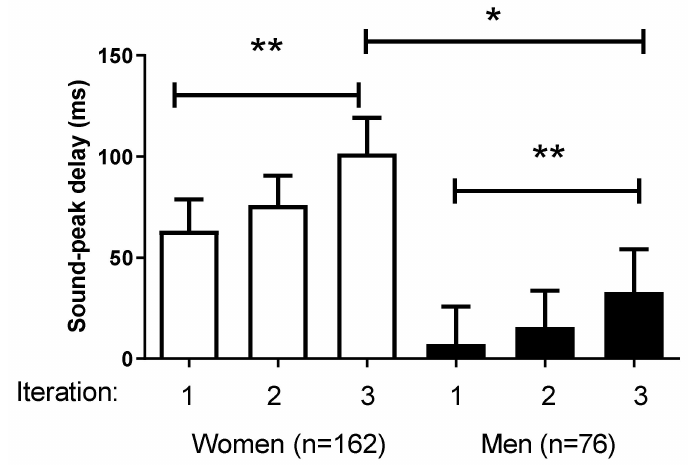
Figure 2. Effect of gender and iteration on PST. PST increased with iteration, and women had a higher PST than men did regardless of the etiology (repeated-measures and two-way mixed-effects model, ** p = 0.0064 for iteration and * p = 0.0153 for gender). PST: peak-sound threshold.